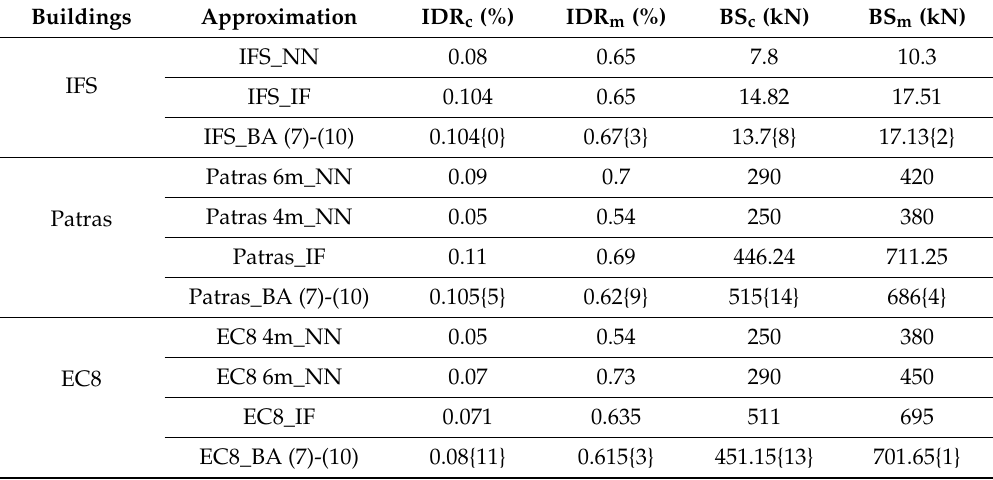
Figure 15. Multi-storey multi-bay frame models capacity curves. Table 14. Evaluation of accuracy of proposed bilinear approximation equations for multi-storey multi-bay frames.